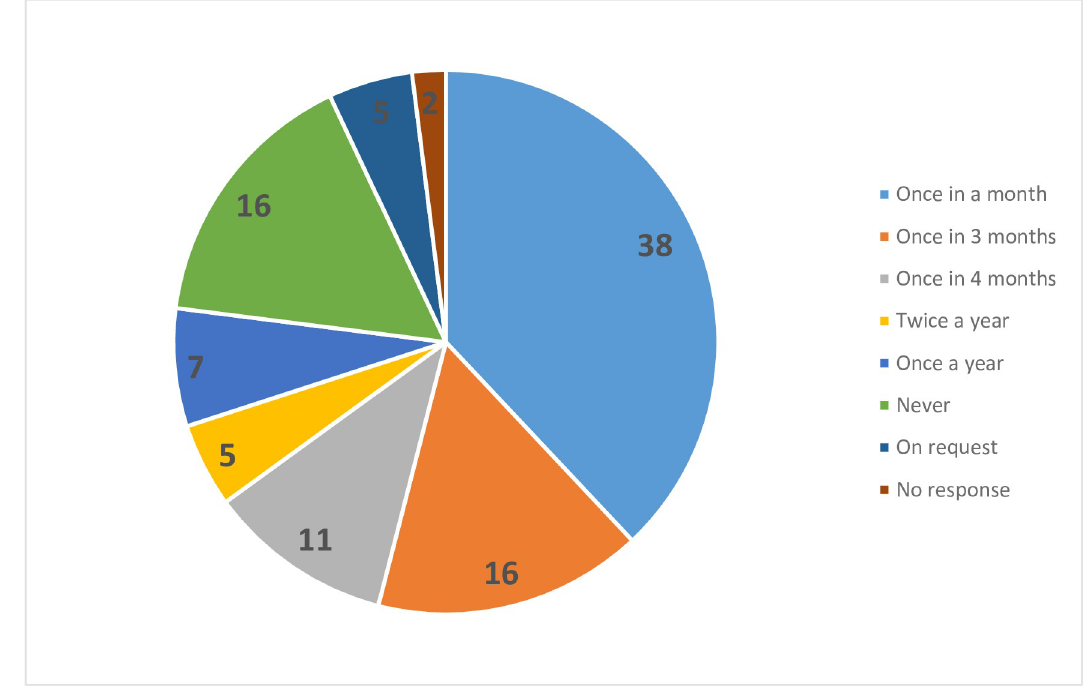
Fig 1. Farmer extension contact. Source: